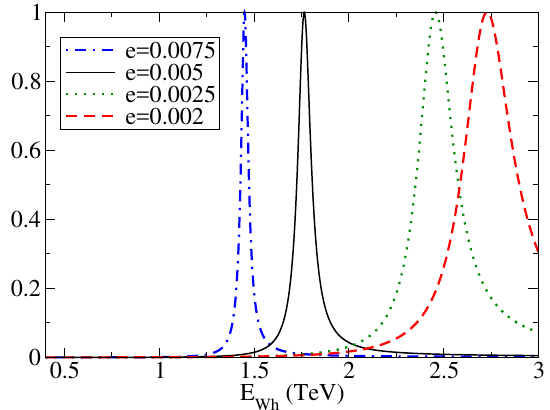
Figure 4 . The I = J = 1 axial resonance generated in V L h scattering with a = 0 . 95. Here we have fixed 2 a 2 b = 1 which is a characteristic prediction of Minimally CHM. We set d = −